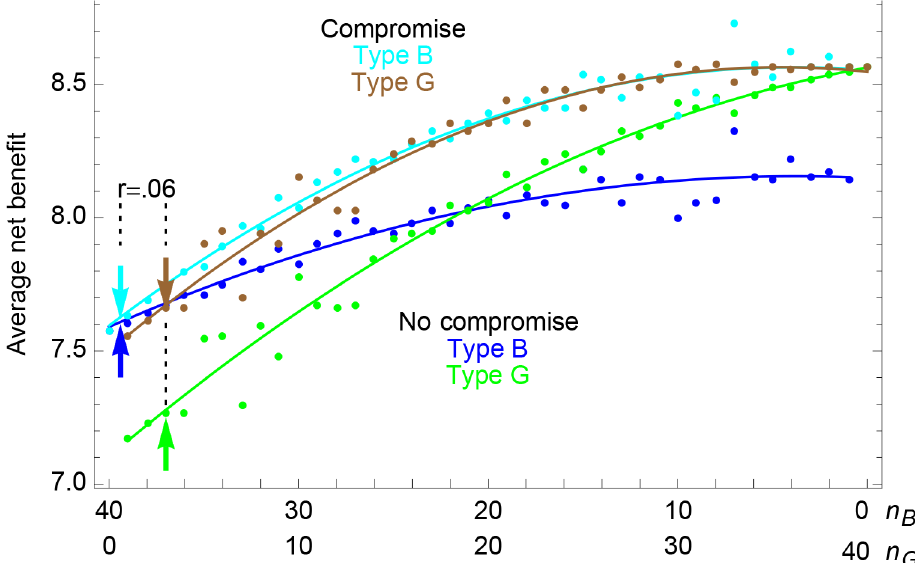
Fig 3. Mixed groups. Average net benefits in mixed groups of 40 players, with n B playing Almost Balanced Reciprocity and n G playing Generalized Reciprocity — or with the two types compromising on an intermediate norm — based on random sampling of players with differing abilities. Lines show quadratic best fits to points. Arrows show that with a modest coefficient of relatedness ( r = .06, suggested by [5, 28]) and no compromise, a rare type G does worse than a common type B, but with compromise, a rare type G does